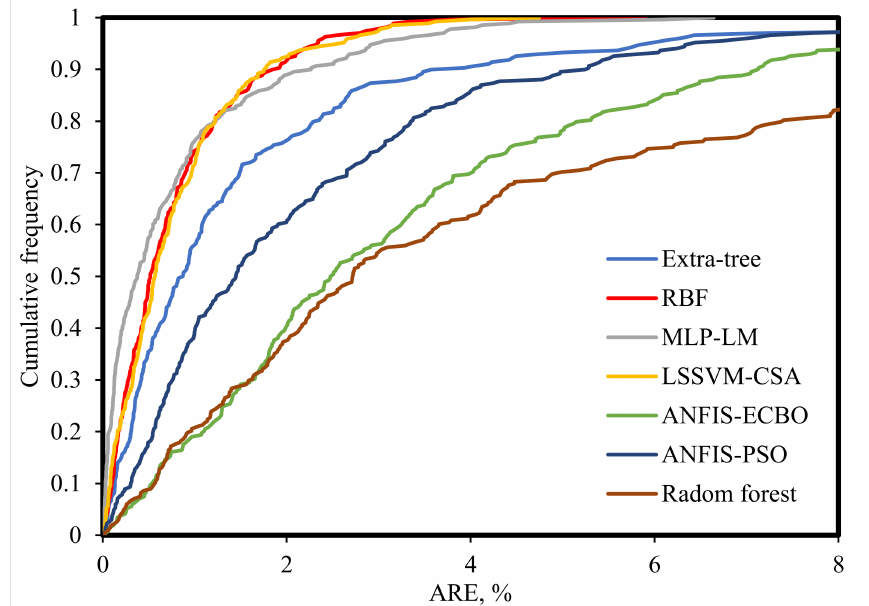
Figure 8. Cumulative frequency against ARE for all of the models.